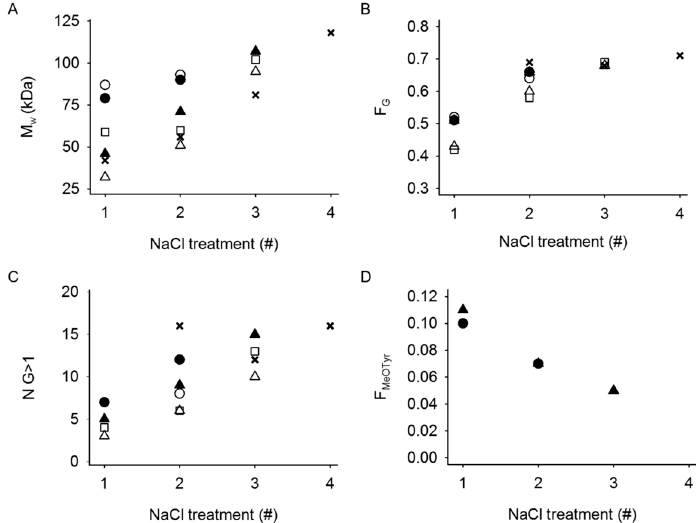
Figure 7. Characterization of leaked alginate from 1.0% w/v alginate/POA ( P 0 = 0.08)